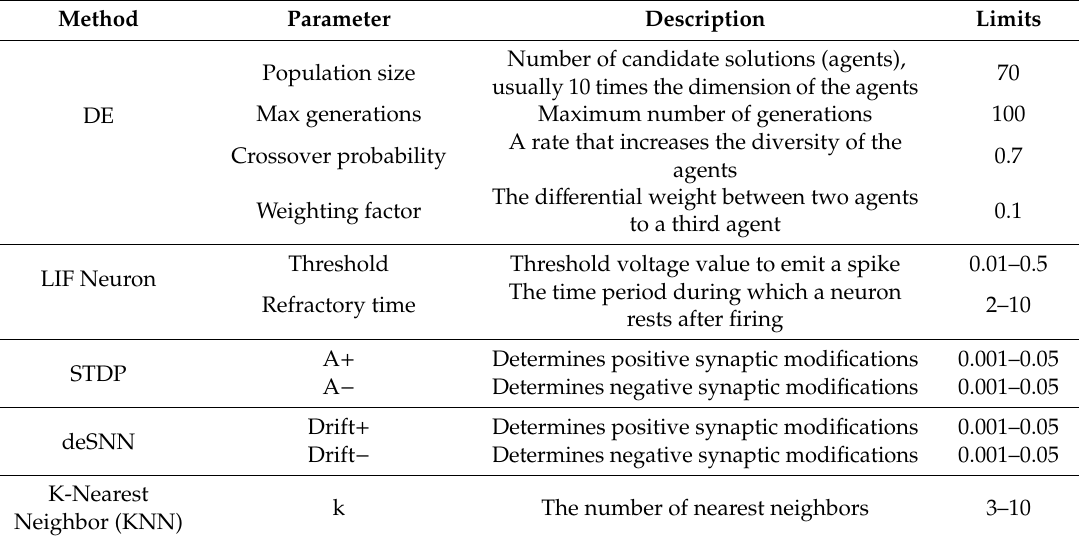
Table 1. Di ff erential evolution (DE) and NeuCube parameters involved in the optimization